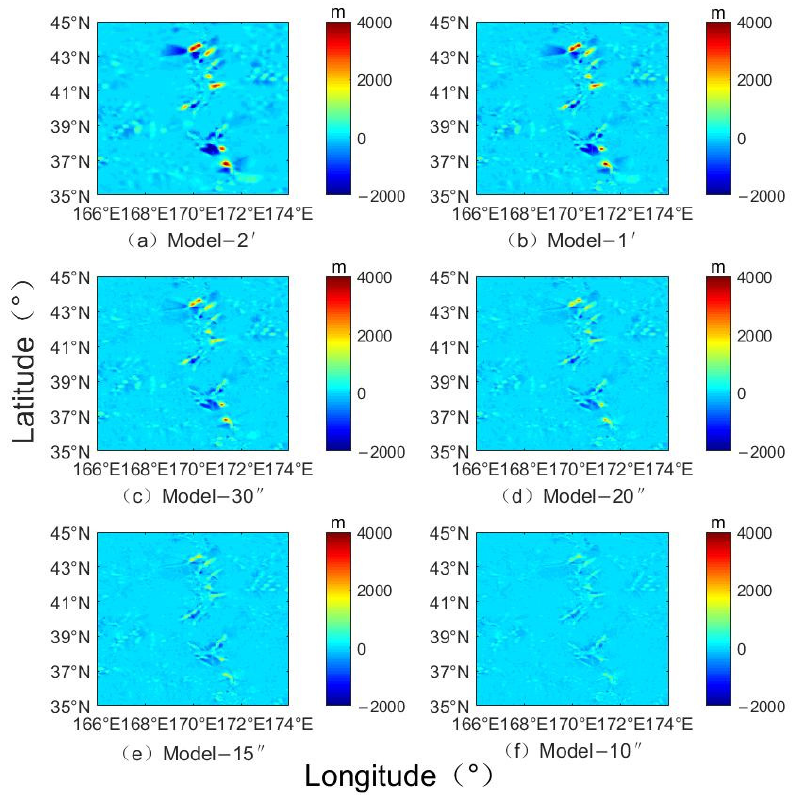
Figure 6. The difference distribution between NGDC grid and inversed topography with different resolutions (m).